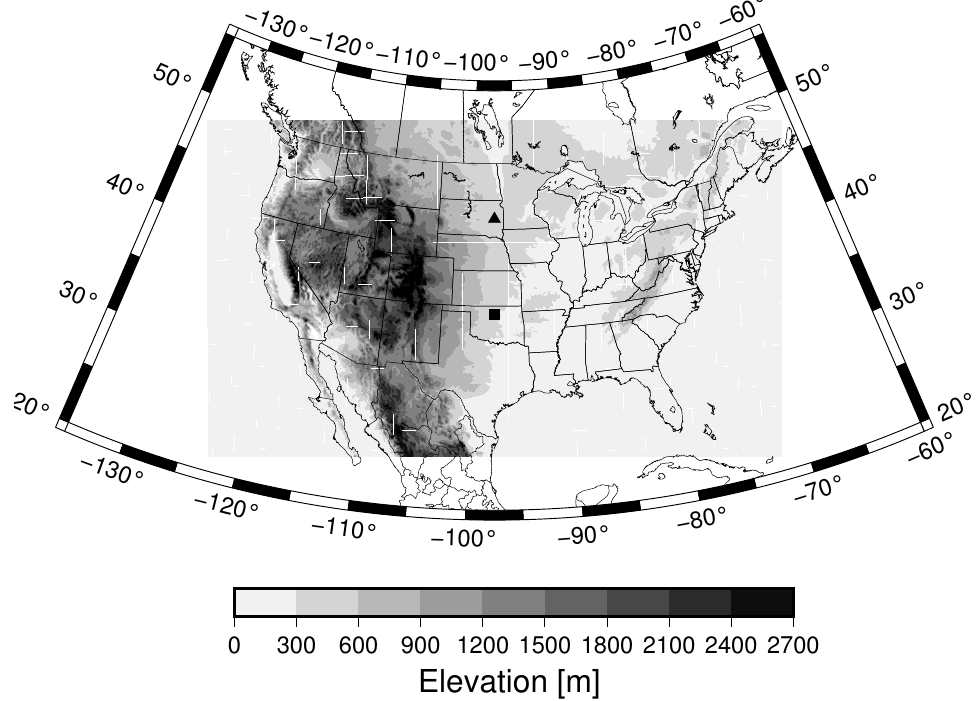
Figure 1. Region covered by the 9 km grid. A rectangle and a triangle mark grid rows with latitudinal changes in the ACM performance discussed in this work. Elevation is also shown (shaded).